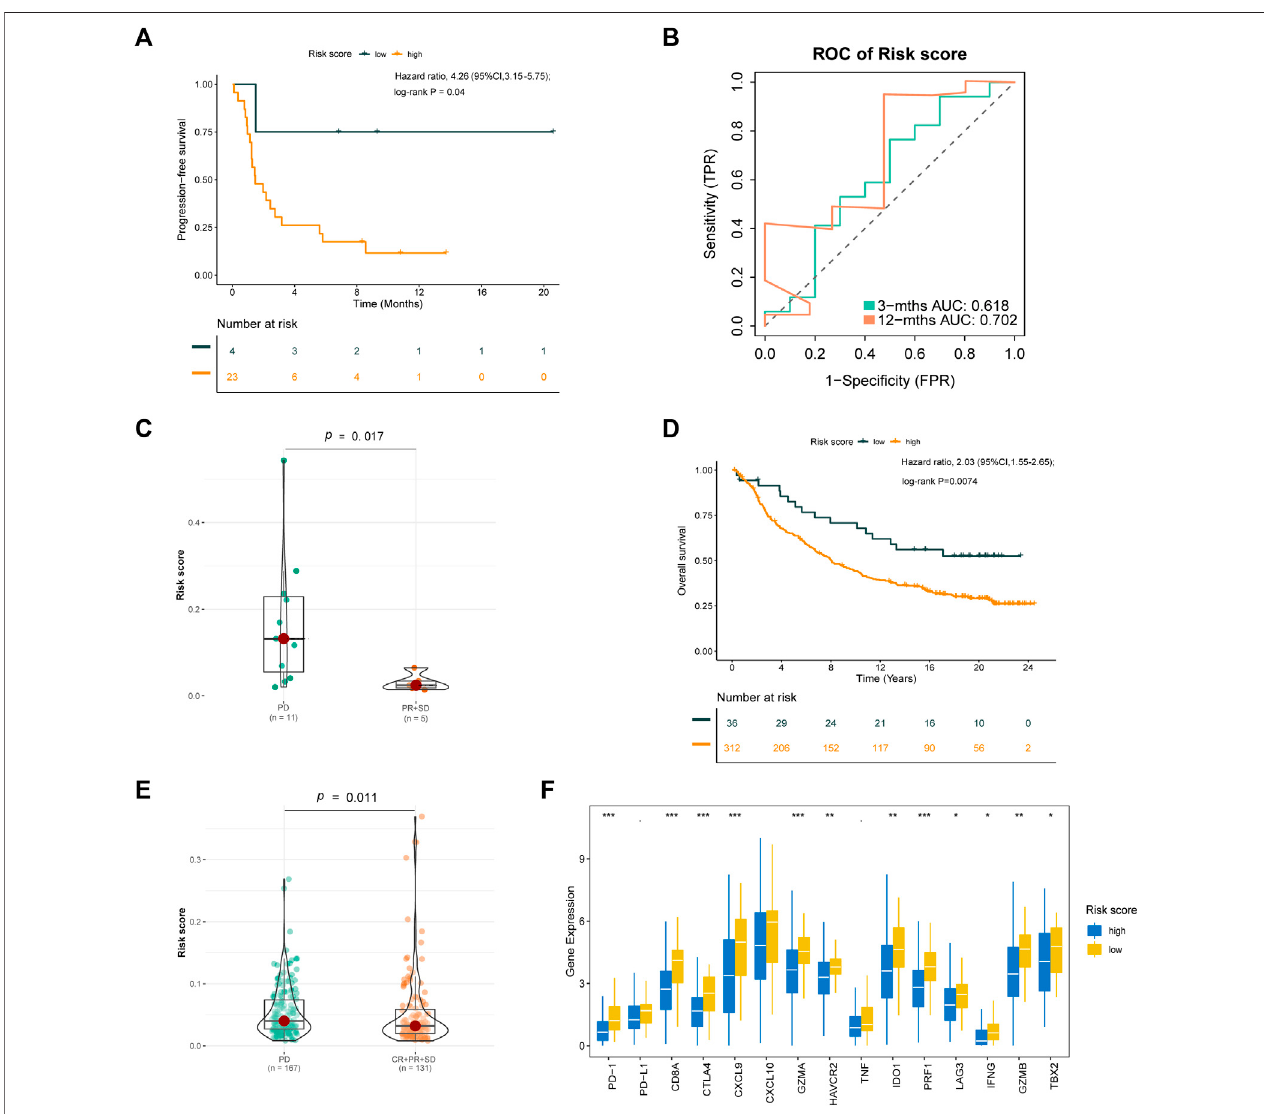
FIGURE12| Validationoftheriskscoreformulaforimmunotherapy. (A) Kaplan-Meier survivalcurveofGSE135222cohortforPFS. (B) Time-related ROCanalysis provedtheprognostic performance oftheriskscoreintheGSE135222. (C) Thedifference ofriskscoreinthe subgroup ofPD-1treatment response inGSE126044. (D) Kaplan-Meier survival curve of IMvigor210 cohort for OS. (E) The difference of Risk score in the subgroup of PD-L1 treatment response. (F) The expression of immue- related checkpoints among high and low risk groups in IMvigor210 cohort. * p < 0.1; * p < 0.05; ** p < 0.01; *** p < 0.001.